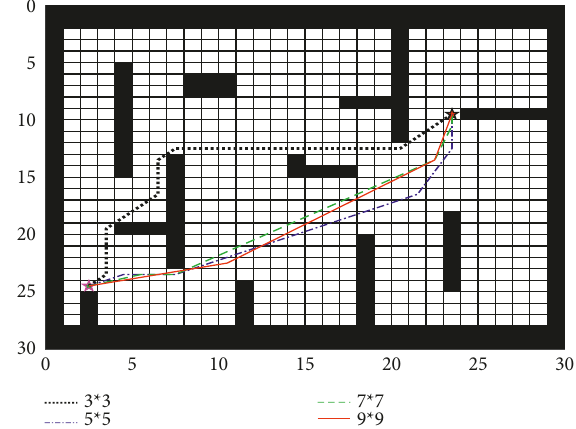
Figure 7: Comparison of paths planned in different search neighborhoods.